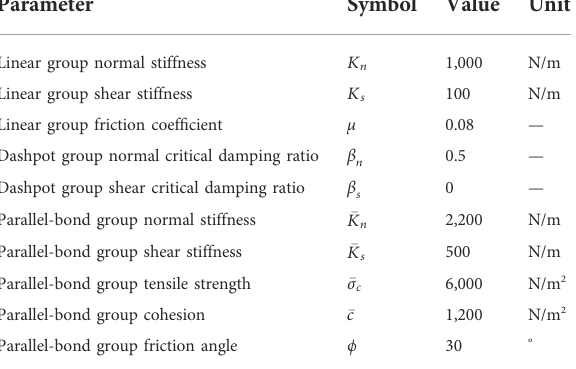
TABLE 5 Mortar- mortar contact parameters.